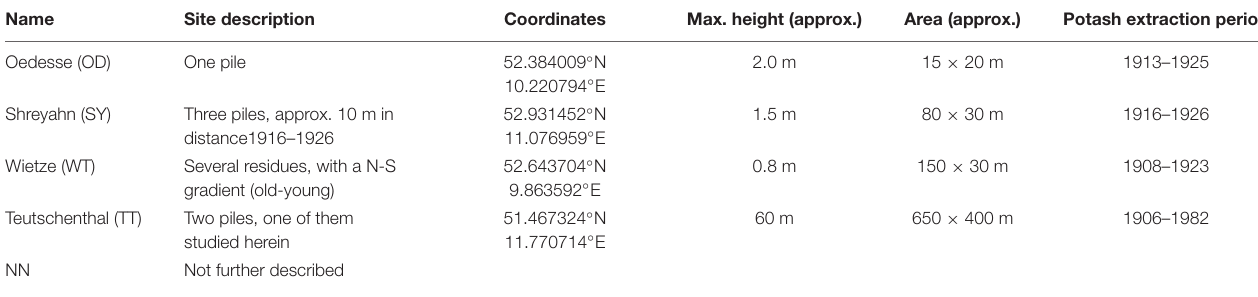
TABLE 1 | Description of the potash tailings pile